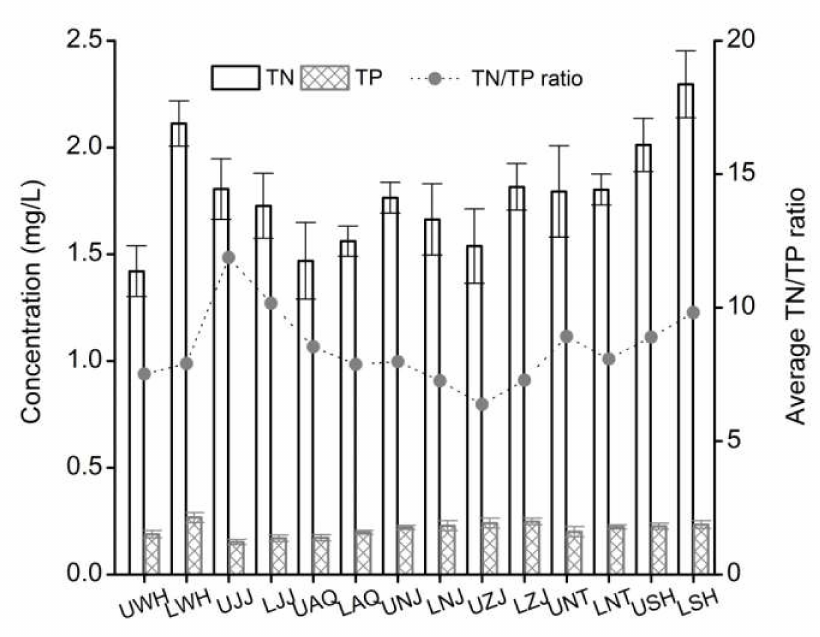
Figure 5. Comparison of total nitrogen (TN), TP, and TN / TP ratio in the upper reaches and the lower reaches of the urban river stretches along the middle and lower reaches of the Yangtze